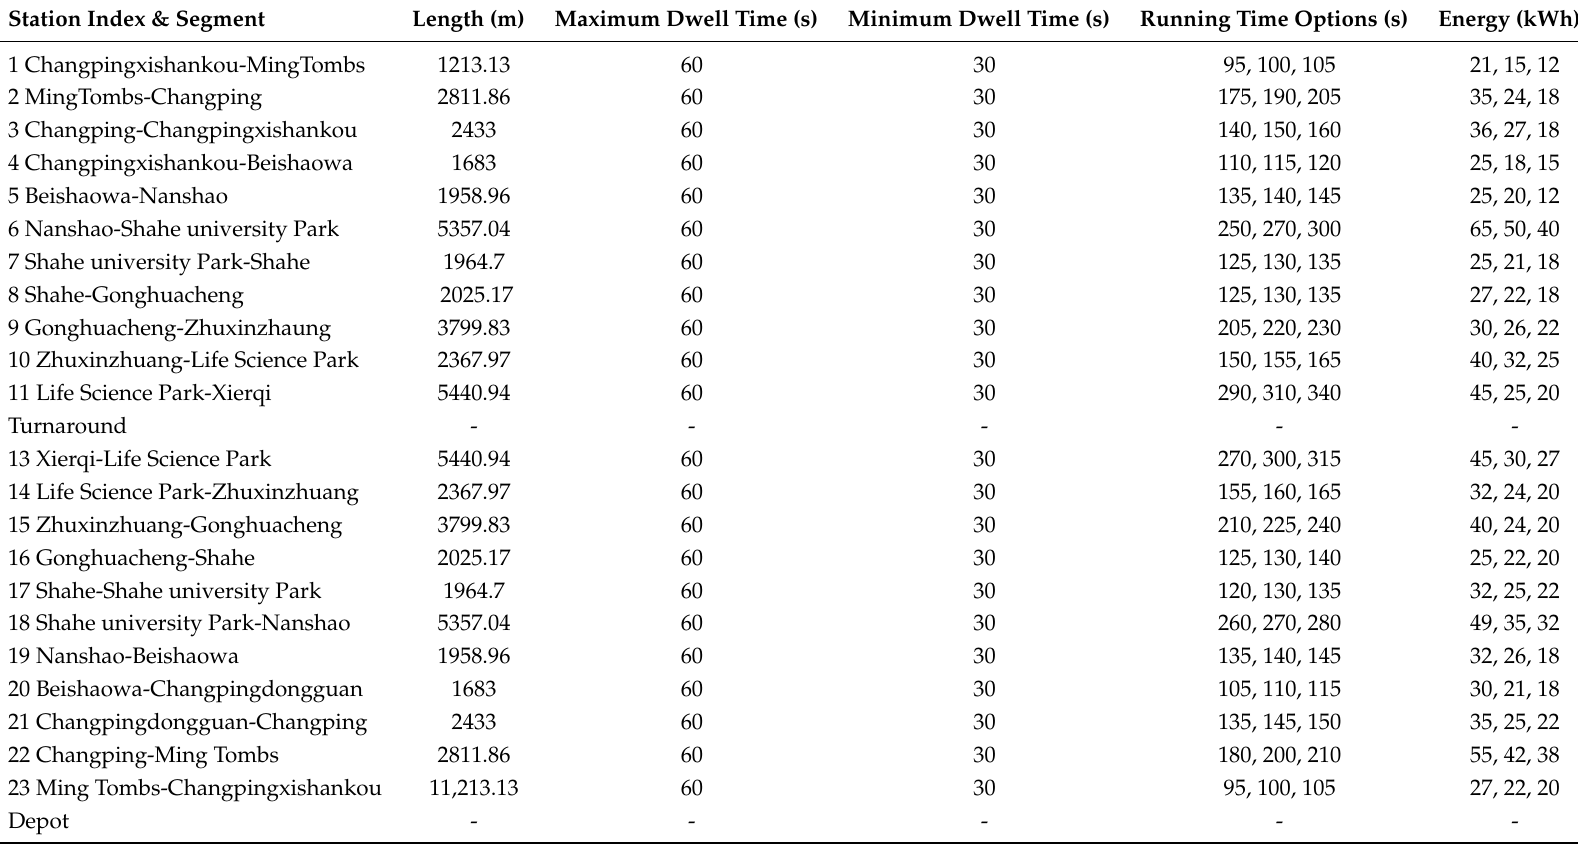
Table 1. Basic line and profile attributes of the Beijing Changping